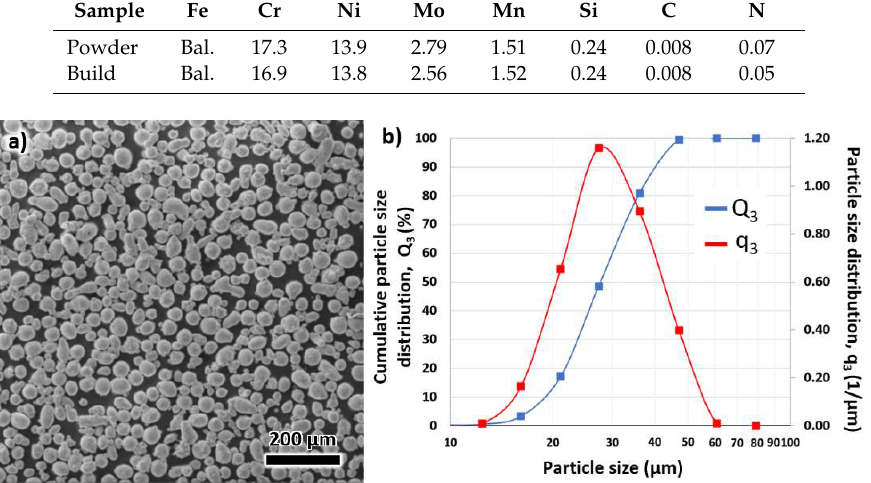
Figure 1. ( a ) Scanning electron microscope image of the 316L powder; and ( b ) the powder size distribution. Q 3 refers to the cumulative size distribution while q 3 indicates the particle size distribution. The diameter of the powders was mostly in the range of 15 – 25 μm.